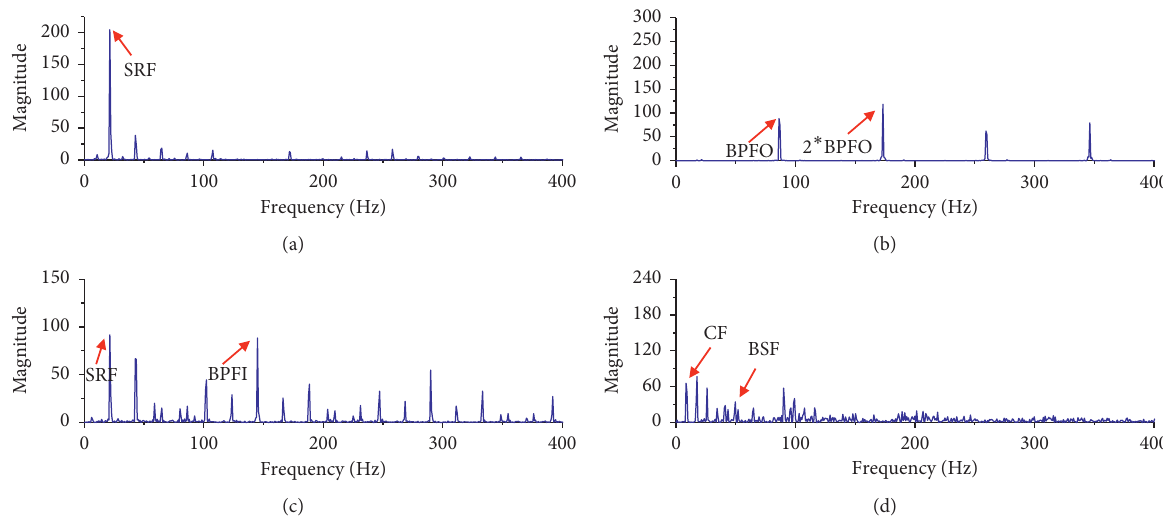
Figure 7: Envelope spectra of the vibration signal in Figure 4. (a) A normal REB and bearings with a point defect on (b) outer race; (c) inner race; (d) rolling